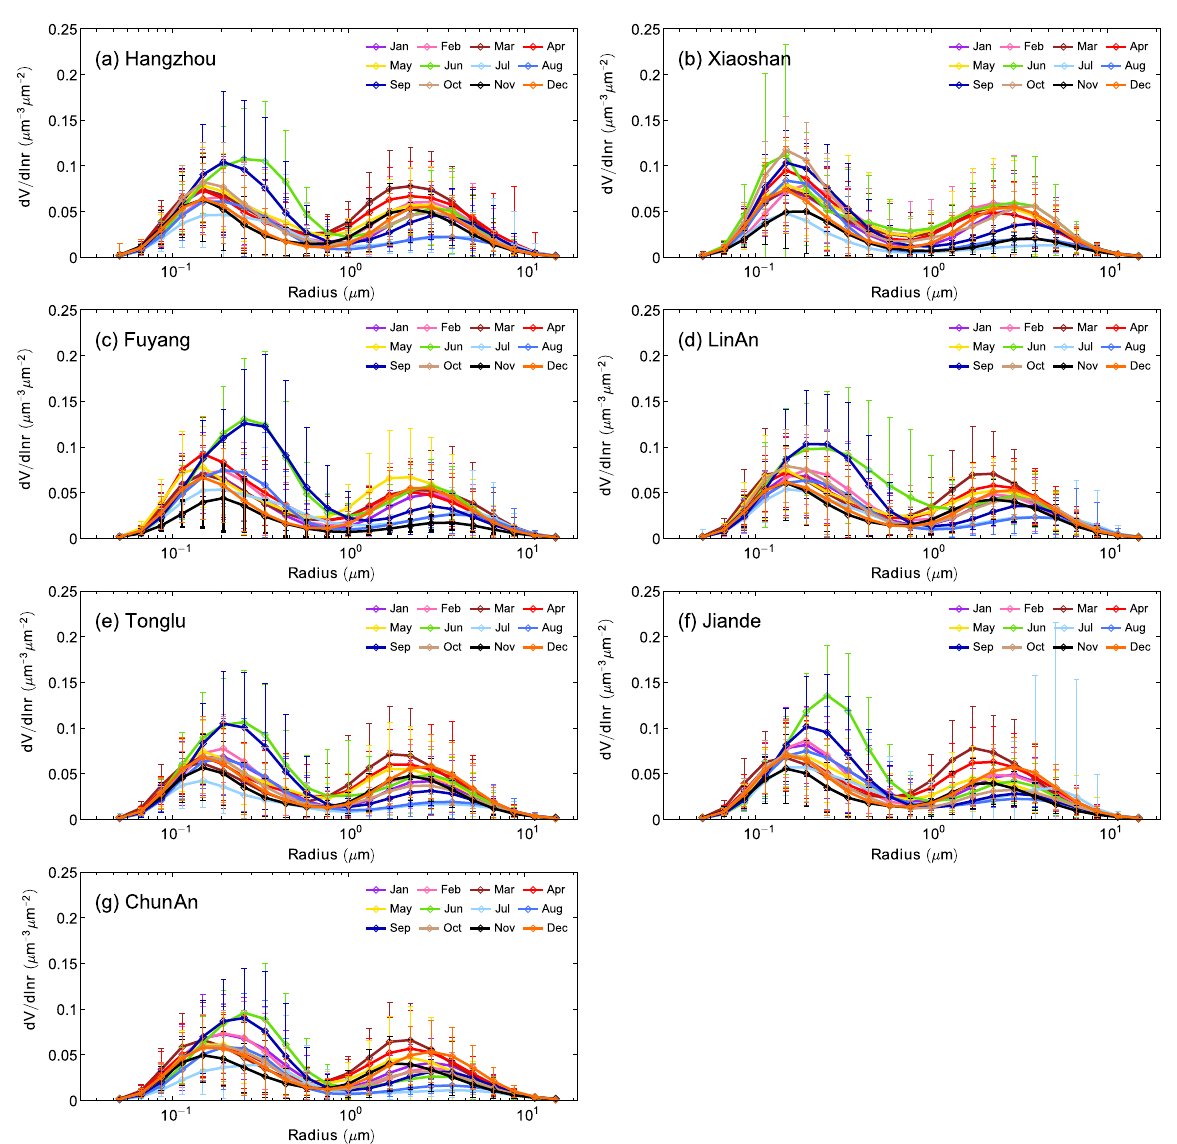
Figure 2. Temporal variations in the aerosol volume-size distributions at (a) Hangzhou, (b) Xiaoshan, (c) Fuyang, (d) LinAn, (e) Tonglu, (f) Jiande and (g)